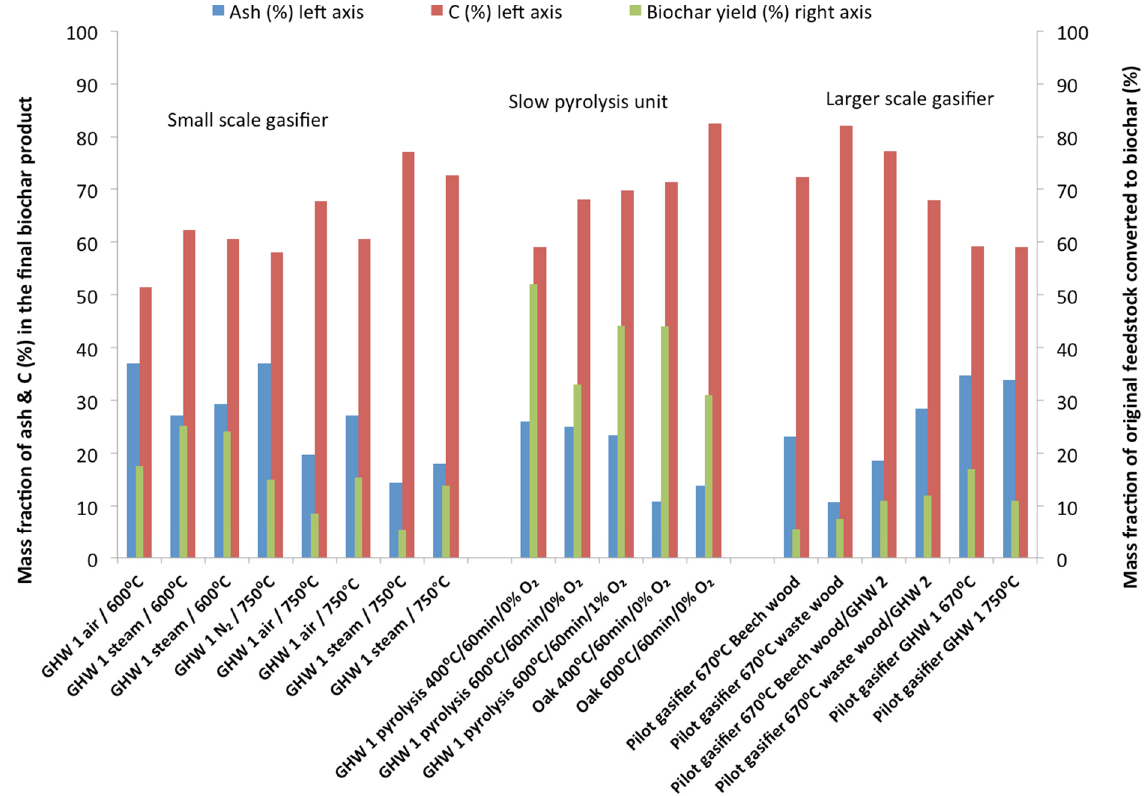
Figure 4. Biochar yield and C content in ash as mass fractions,